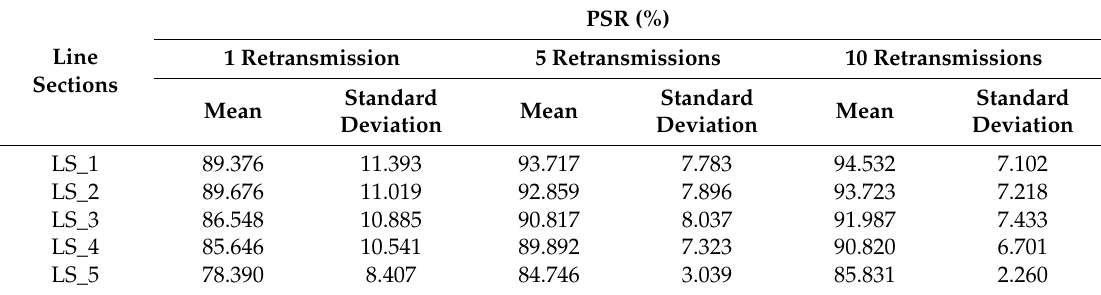
Table 6. PSR results for a Fault Management System (FMS) with 1, 5, and 10